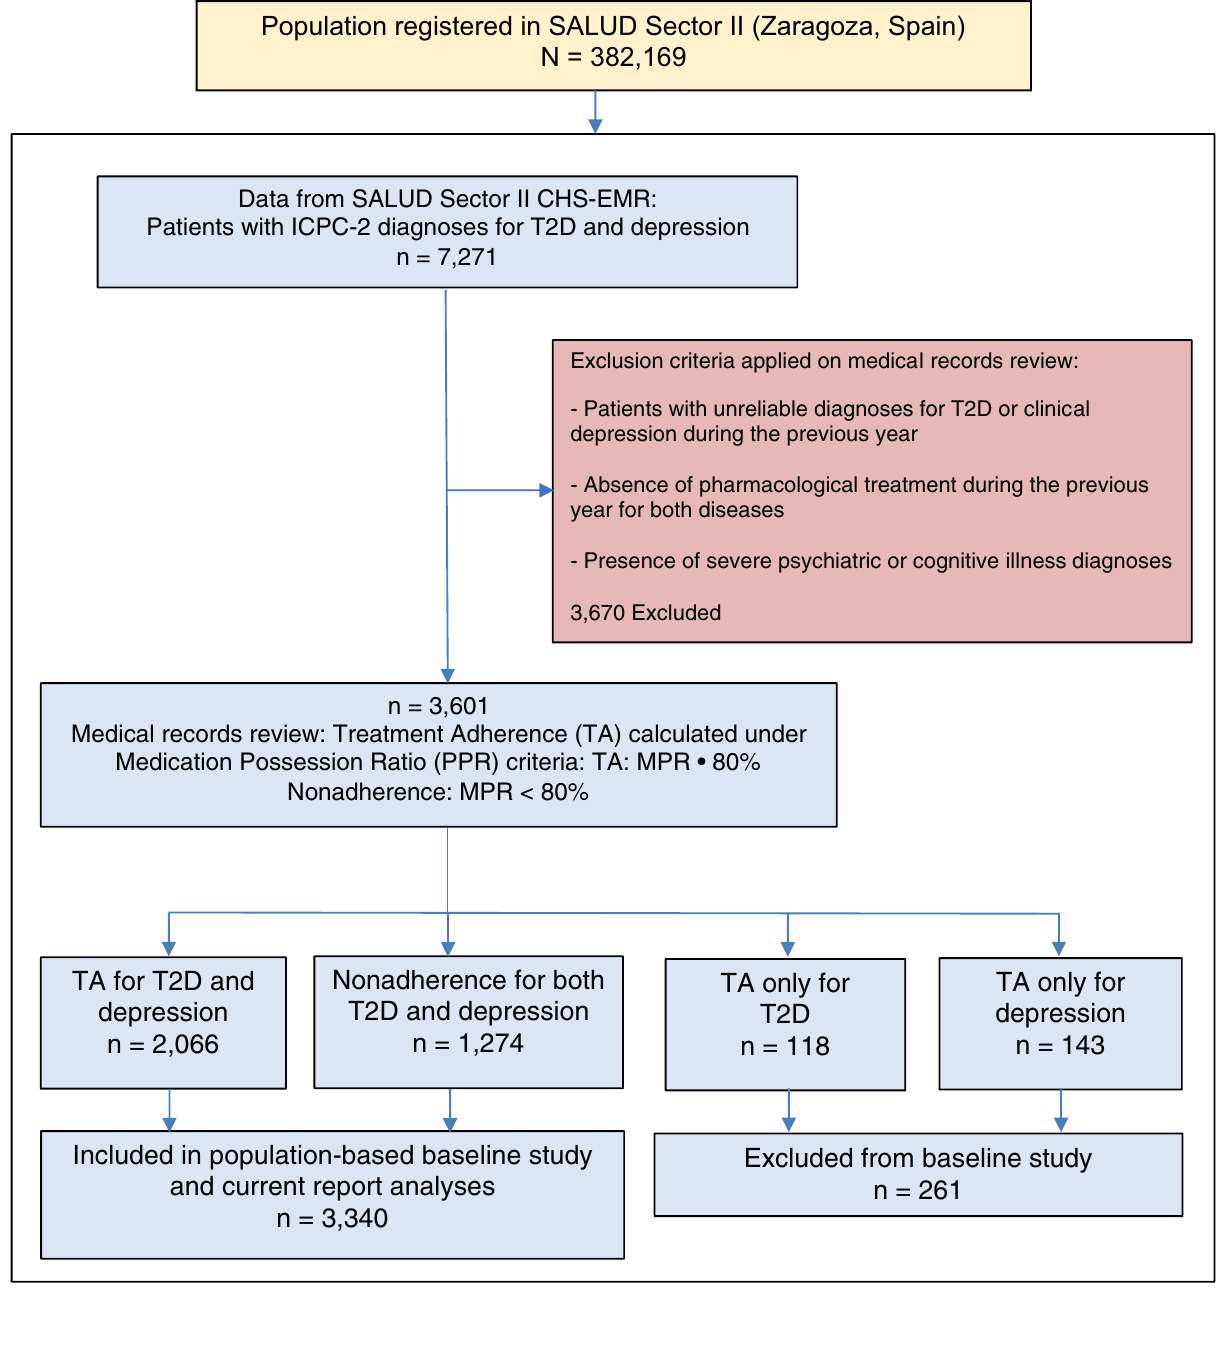
Figure 1. TELE-DD project